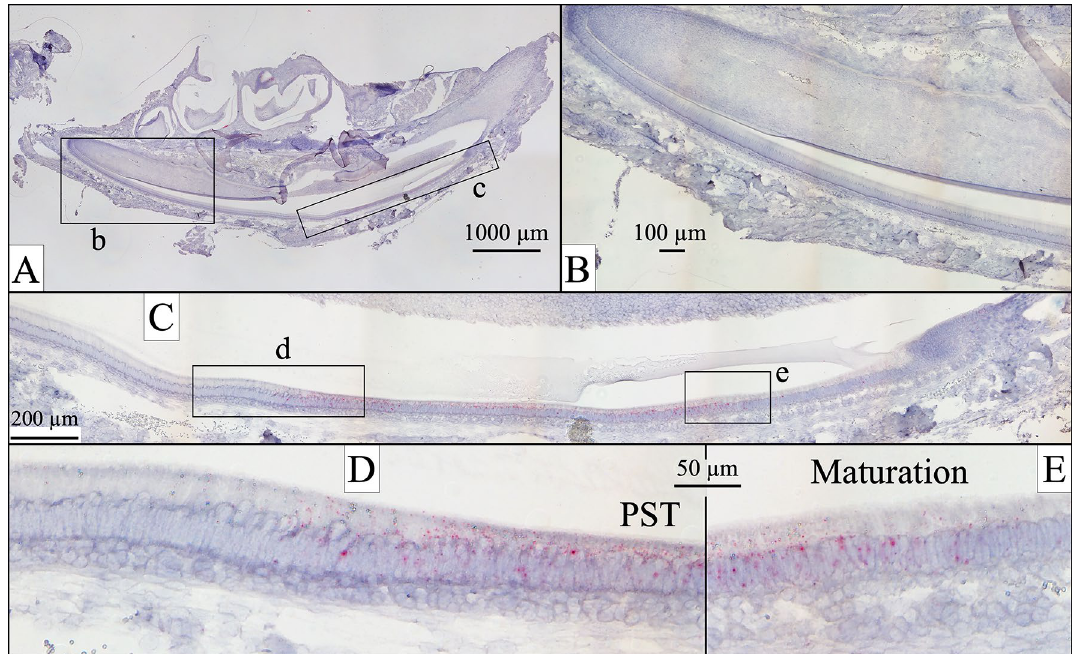
Figure 2. Odaph Expression in Odaph +/+ Day 12 Mandibular Incisors. In the continuously growing mandibular incisor enamel formation progressively advances from basal (left) to incisal (right). ( A ) Sagittal section of a D12 mouse hemimandible. Boxes show the locations of the higher magnification views in ( B ) and ( C ). ( B ) Odaph expression was absent or trace in presecretory and secretory stage ameloblasts. ( C ) Late secretory, post- secretory transition (PST) and early maturation stages of amelogenesis. Boxes show the locations of the